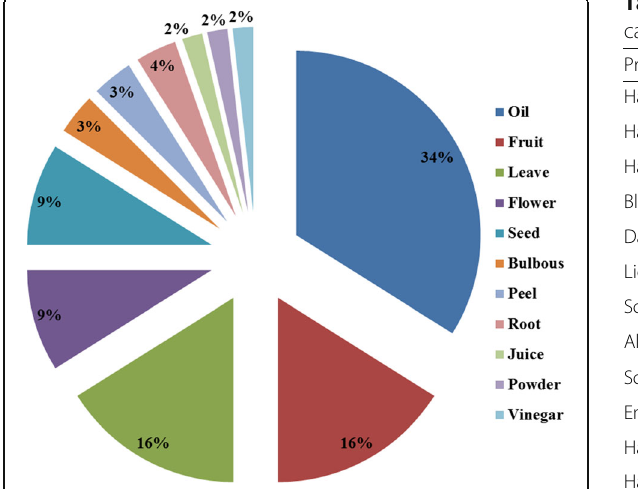
Fig. 3 The parts used of herbals in cosmetics